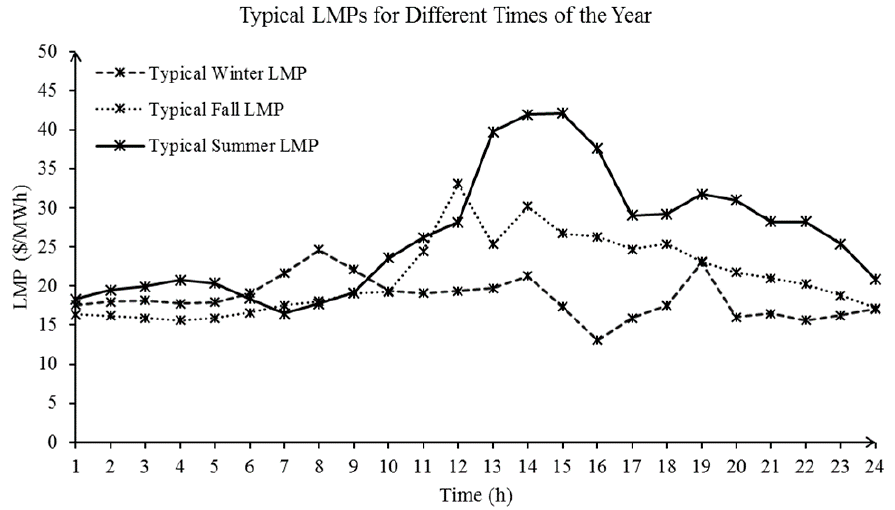
Figure 4. Realistic locational marginal price (LMP) values for different seasons.